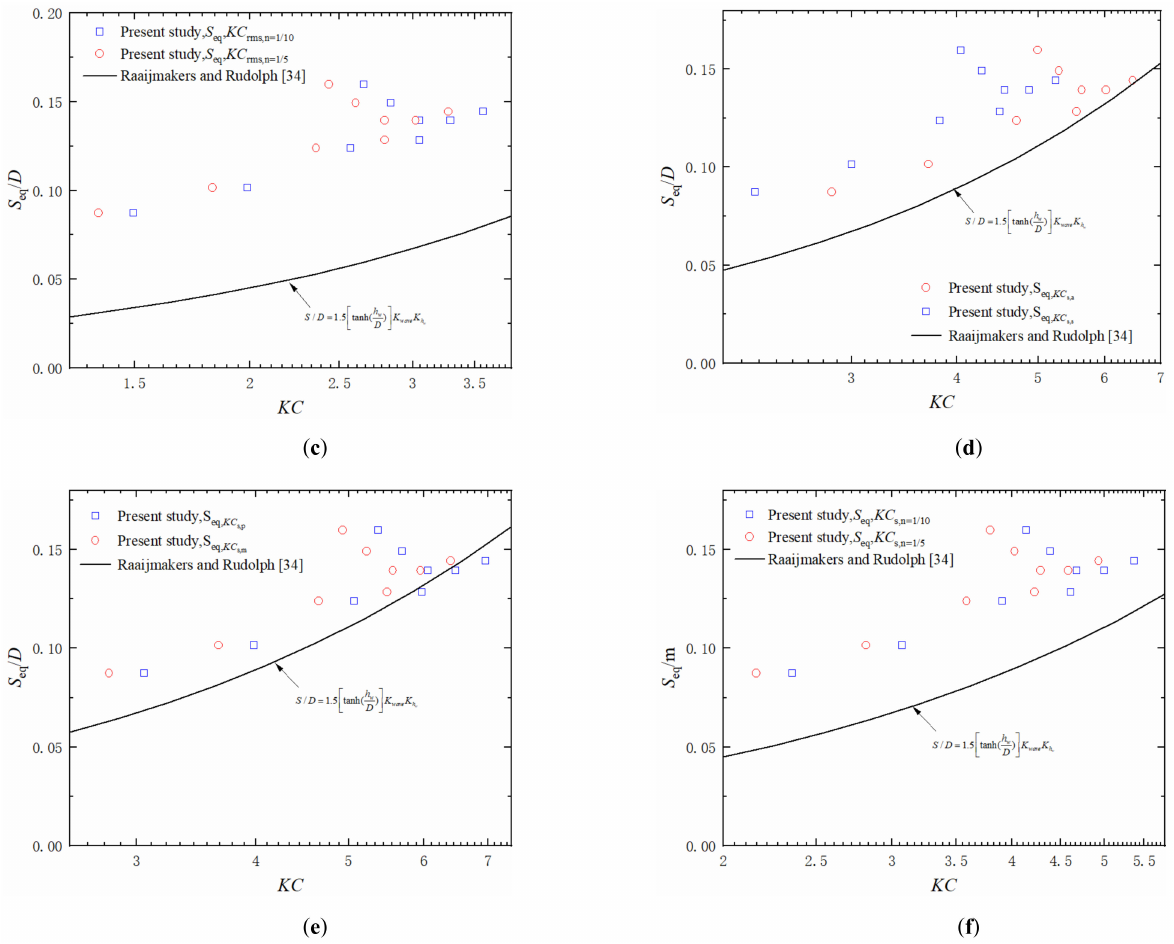
Figure 15. Comparison of the equilibrium scour depth between the present model and the model of Raaijmakers and Rudolph [34]: ( a ) KC rms,s , KC rms,a ; ( b ) KC rms,p , KC rms,m ; ( c ) KC rms,n = 1/10 , KC rms,n = 1/5 ; ( d ) KC s,s , KC s,a ; ( e ) KC s,p , KC s,m ; ( f ) KC s,n = 1/10 , KC s,n = 1/5